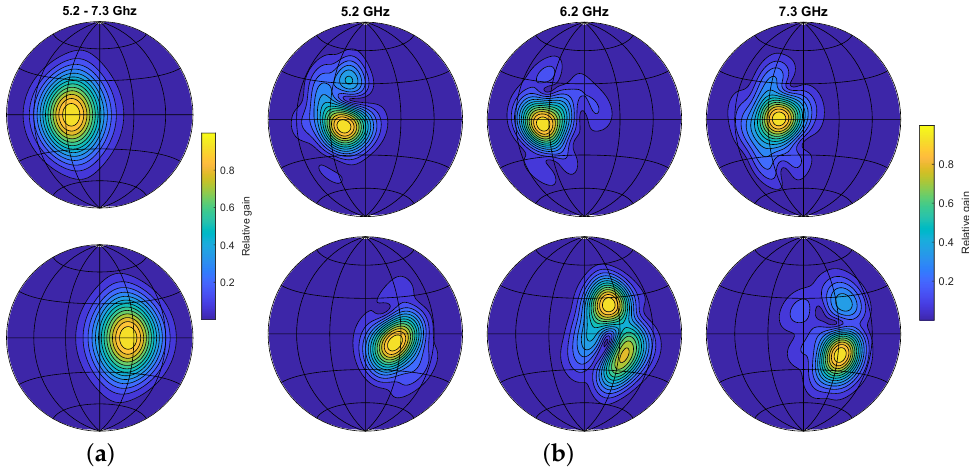
Figure 9. Lambert azimuthal equal-area projection of the echo-related transfer functions (ERTFs) used for the SLAM comparison. Top row represents the left channel, bottom row right channel. ( a ) ERTF with static lobe directivity. ( b ) ERTF with added spatiospectral